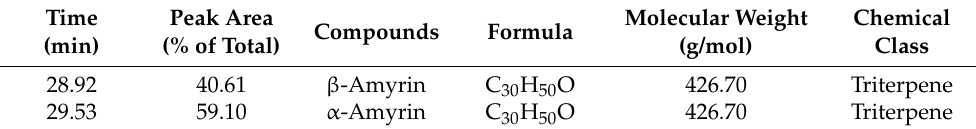
Figure 1. GC-MS chromatogram ( a ) and mass spectra ( b ) of α -amyrin and β -amyrin. Table 1. α -Amyrin and β -amyrin identified by GC-MS.